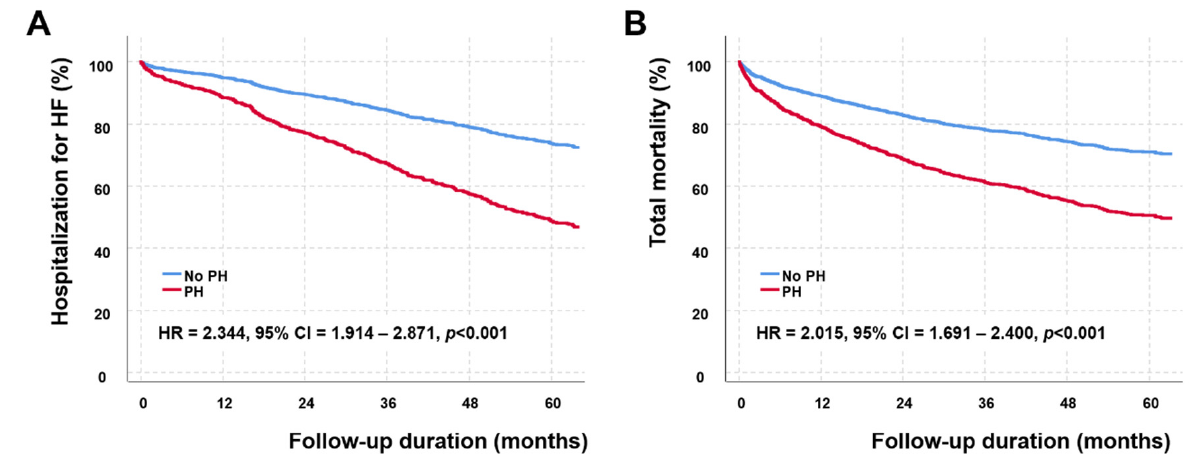
Figure 2. Event-free survival ( A ) and total survival ( B ) curves according to the presence of pulmonary hypertension associated with left heart disease (PH-LHD). Patients with PH-LHD have significantly higher hospitalization for heart failure (hazard ratio (HR) = 2.344, 95% confidence interval (CI) = 1.914–2.871, p < 0.001) and all-cause mortality (HR = 2.015, 95% CI = 1.691–2.400, p < 0.001)